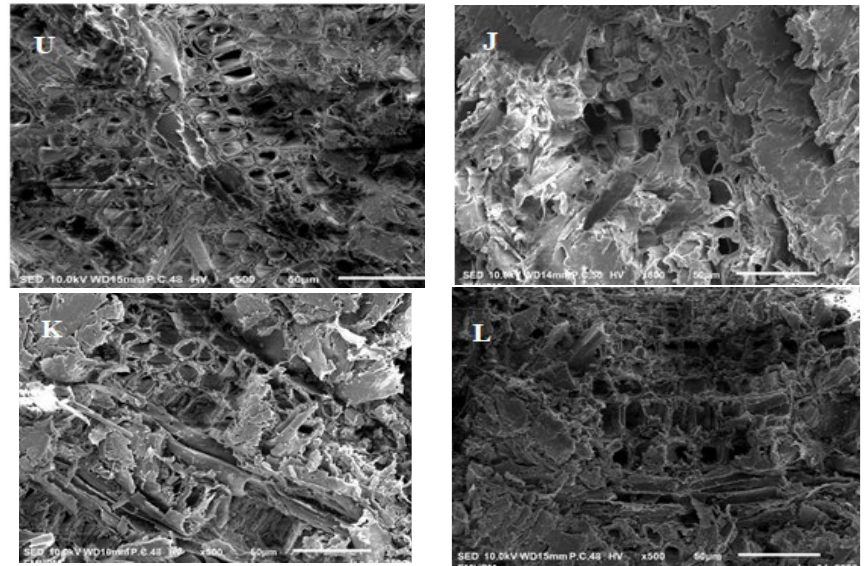
Figure 4. Cross-sections after hydrothermal treatment on control ( U ), pH 8, 160 °C ( J ), pH 8, 180 °C, and ( K ), pH 8, 200 °C ( L ).